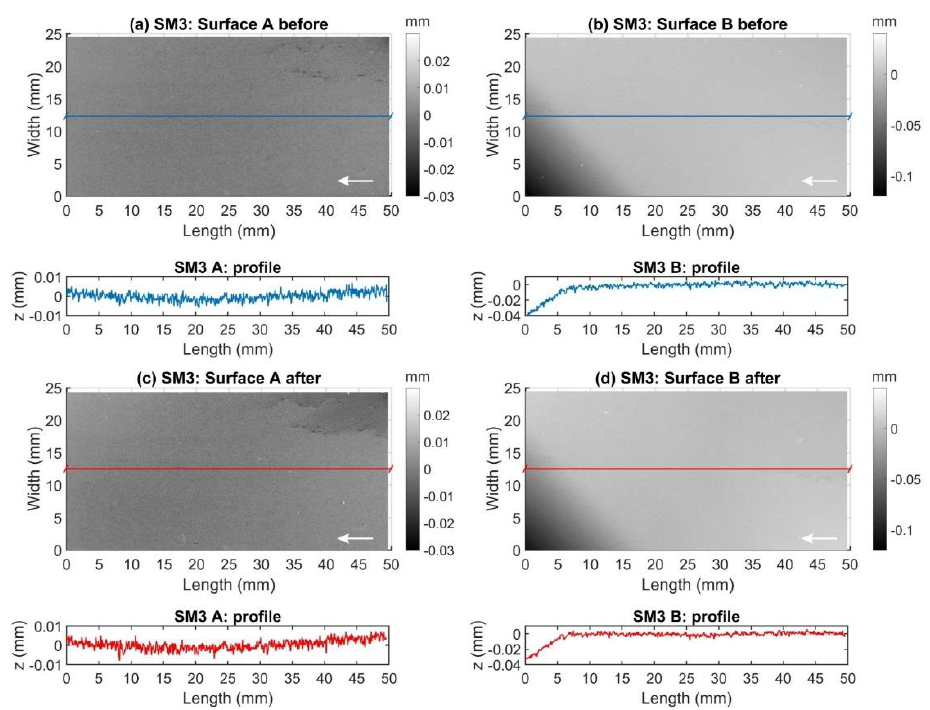
Figure A3. Fracture surface topographies and the central profiles of sample SM3 before ( a , b ) and after ( c , d ) the entire experiments, where the arrows indicate the flow direction.